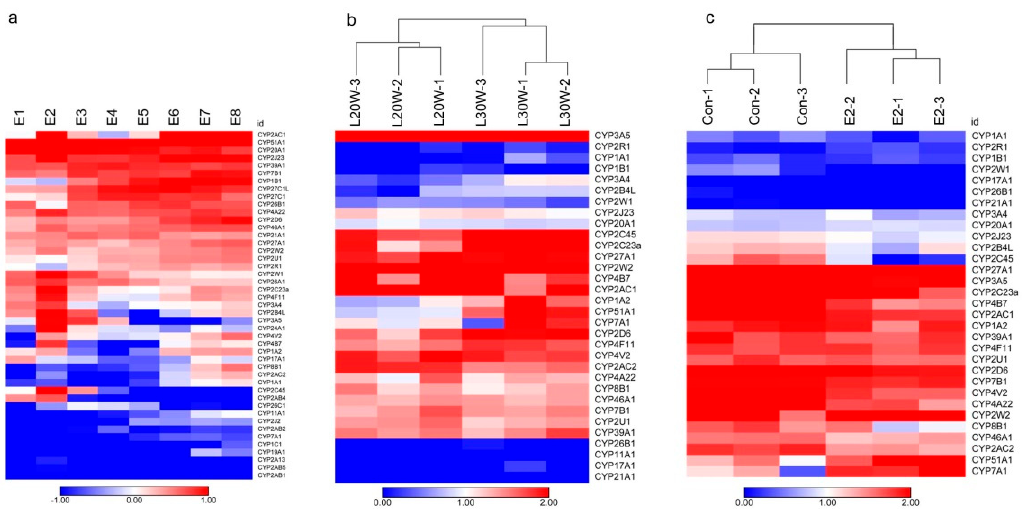
Figure 4. Heat maps showing the mRNA expression profiles of cCYPs. ( a ) Expression profiles of cCYPs in developmental stages of chicken embryos. ( b ) Expression profiles of cCYPs in the liver of pre-laying and laying hens. ( c ) Expression profiles of cCYPs in the liver of 17 β -estradiol treated and non-treated chickens. The genes expression levels were obtained based on transcriptional data. The relative expression was log transformed and visualized as heat maps.